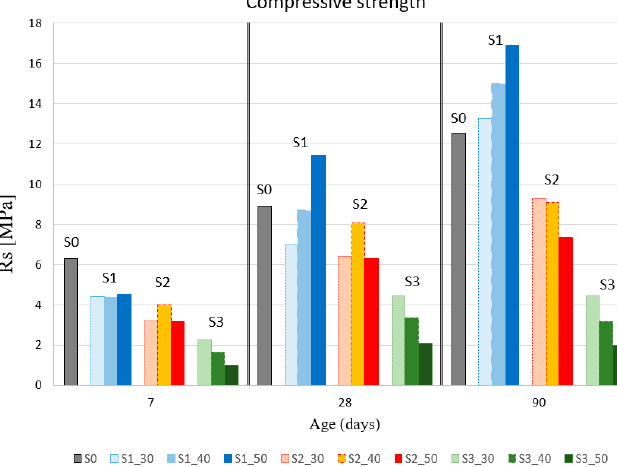
Figure 6. Results of compressive strength test (Rs)(MPa).